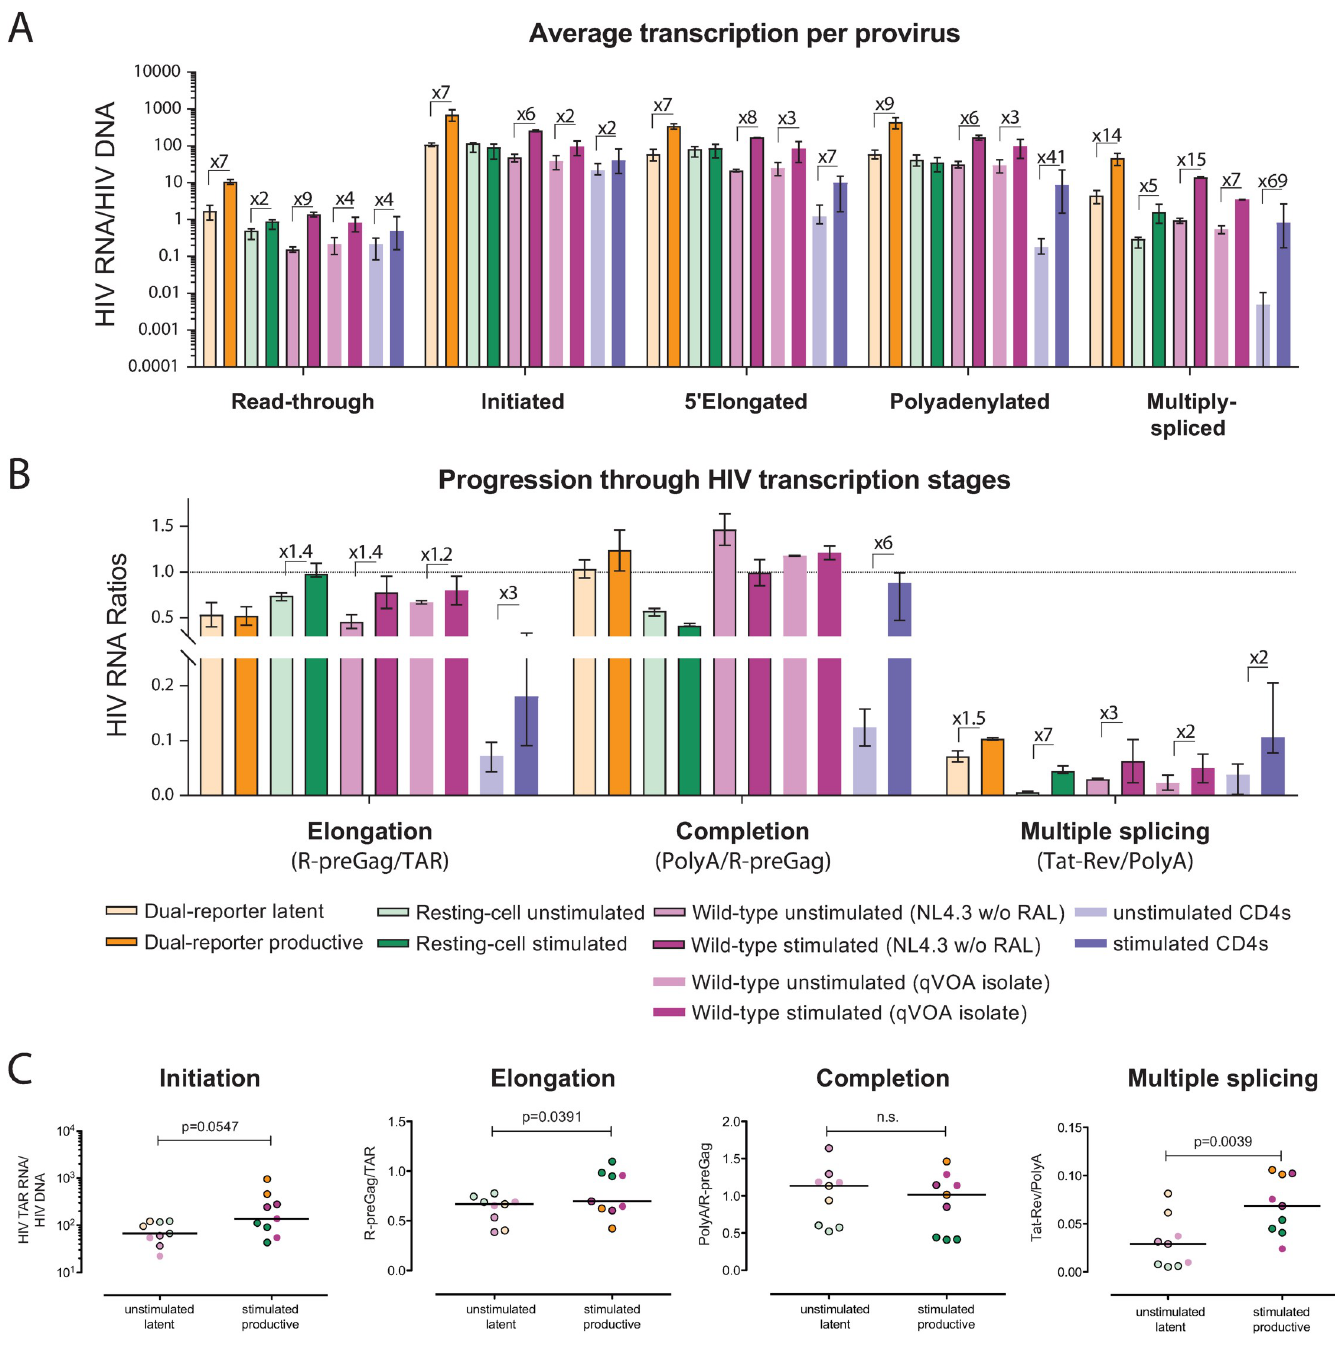
Fig 5. Primary cell HIV latency models recapitulate the block to multiple splicing observed in CD4 + T cells from ART-suppressed individuals. Comparison of (A) Level of HIV transcripts per provirus, and (B) progression through HIV transcription stages in cells from the Dual-reporter (orange), the Resting-cell (green) and the Wild-type (purple) primary cell models, and cells from ART-suppressed individuals (blue), in latently- (light color) and productively-infected or stimulated cells (dark color). Median and range (bars) are shown. (C) Comparison of HIV transcriptional initiation, elongation, completion, and multiple splicing in the latent (unstimulated) and productive (stimulated) populations in all donors from the three main models shown in Figs 2–4. Bars indicate the median; P-values were calculated using the Wilcoxon signed rank test.